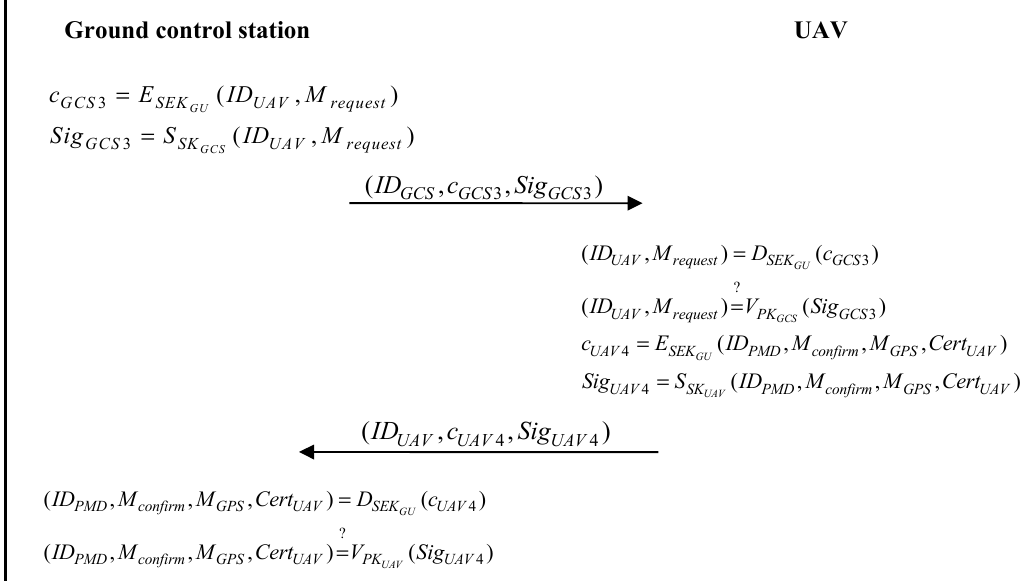
Figure 8. Ground control station and UAV authentication and communication phase of the proposed scheme.